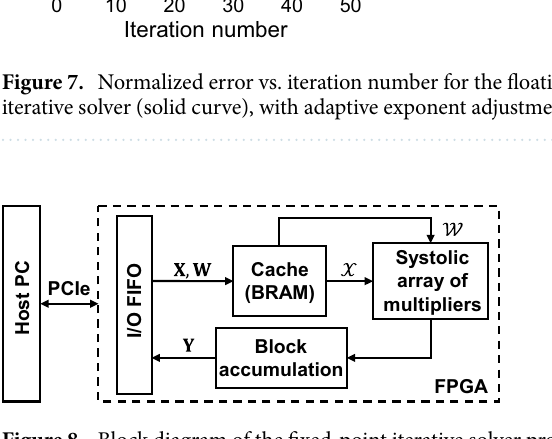
Figure 8. Block diagram of the fixed-point iterative solver prototype on FPGA depicting the communications and among systolic multiplier array, cache, accumulator, and other resources. FIFO: first-in-first-out; BRAM: block random-access